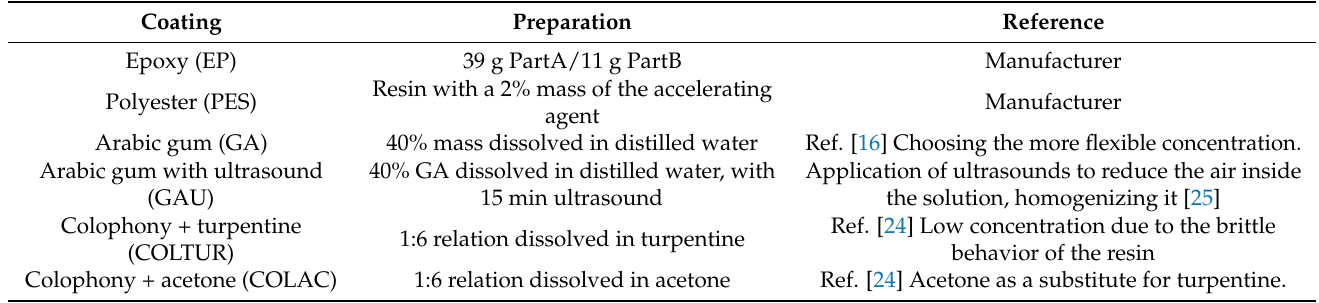
Table 4. Coating types and preparation.